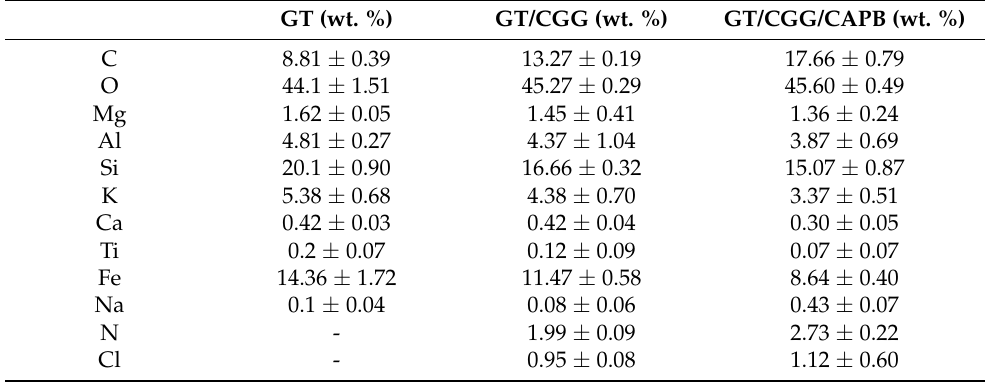
Table 4. The qquantitative analysis of the surface composition of pure and modified GT by